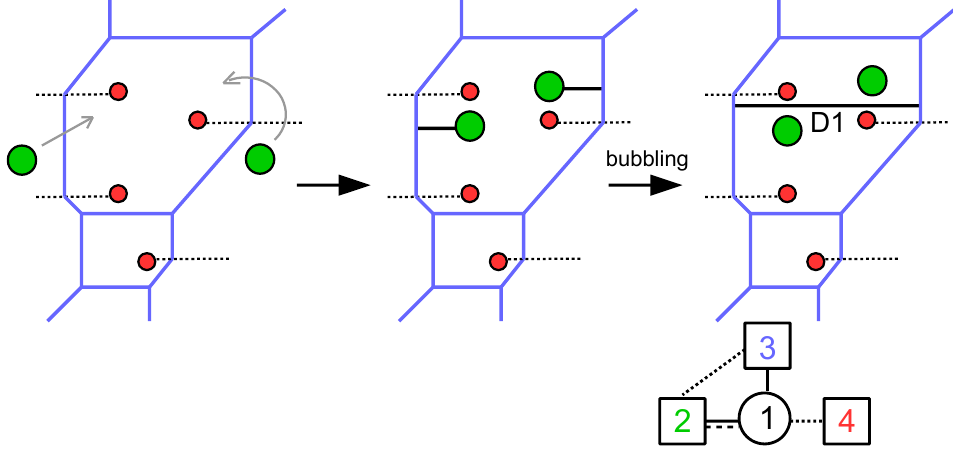
Figure 11 . Moving the D3s inside the web, through NS5 branes, we reach a con(cid:12)guration that can bubble. On the right: bubbling con(cid:12)guration for L 1 ; 1 in the SU(2) N f = 4